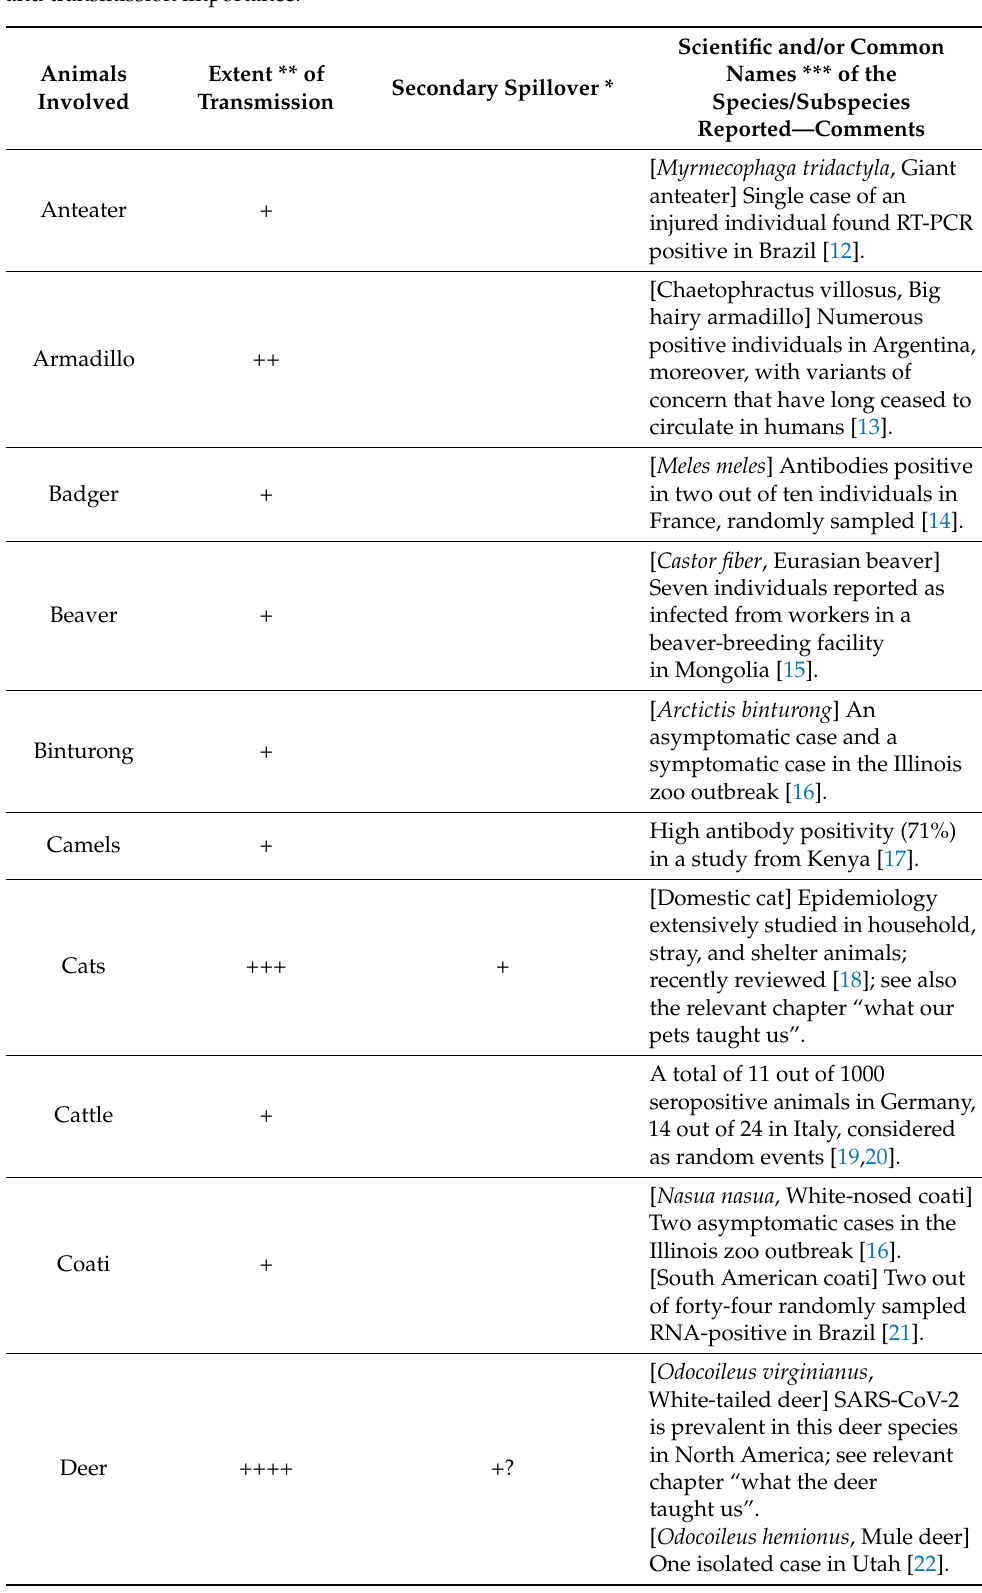
Table 1. Animals (in alphabetical order) implicated in zooanthroponotic SARS-CoV-2 transmission and transmission